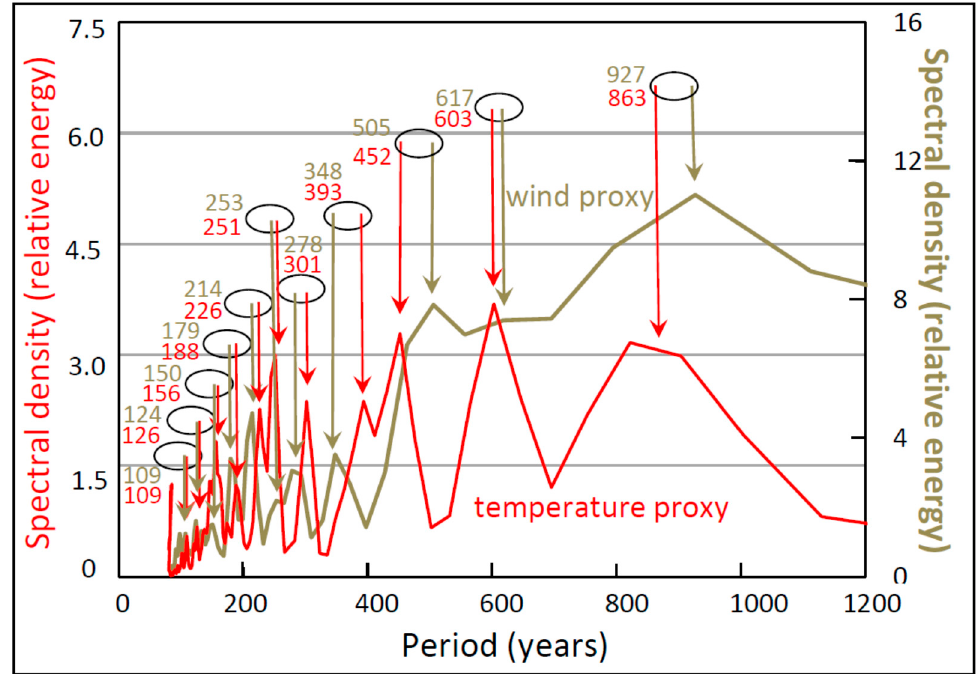
Figure 9. Spectral density periodograms showing similar spectral frequency profiles of dust flux at EPICA Dome C (EDC, brown curve) and a temperature proxy at nearby Vostok (red curve) for the Holocene from 6000-397 years before 1950 (Yb1950). Ovals enclose shafts of arrows that identify the most closely matched peaks at the periods in years shown beside each oval. Fischer’s Kappa statistic and corresponding probability that the distribution is discernibly different from white noise are (dust-flux record) 4.95 and 0.38, and (temperature record) 17.3 and 8.7e-7. The statistical discernibility of individual spectral density peaks was not computed, although by analogy with previous research [12] (Figure 3), the largest 6-9 peaks are likely candidates for discernibility at p < 0.05.